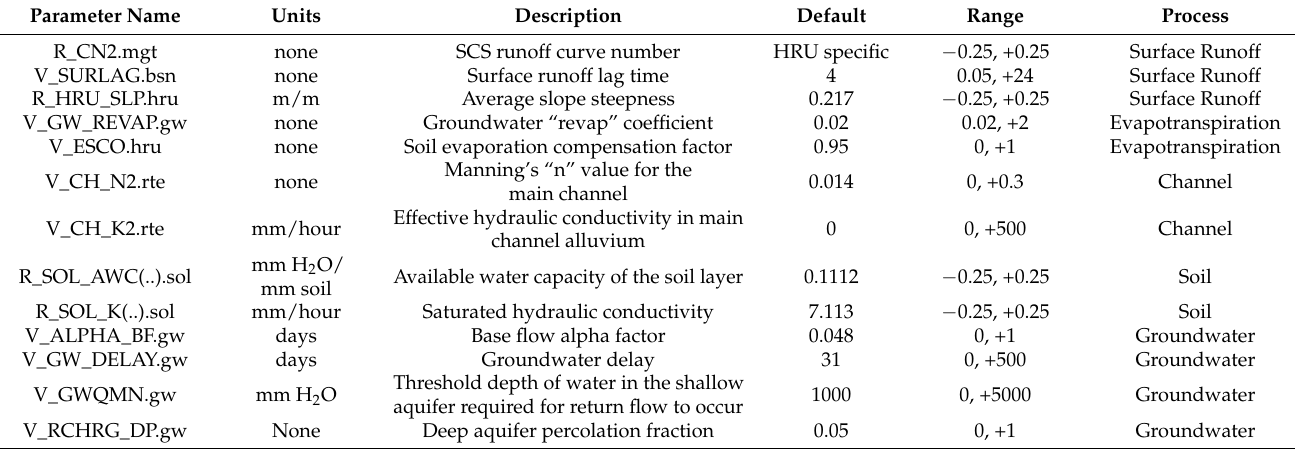
Table A2. Name, description, range and control processes of SWAT parameters. “r_”, “v_”, and “a_” refer to modify the default value by making a relative change to the default value, replacing the default value by the specific value and adding a specific value, respectively.